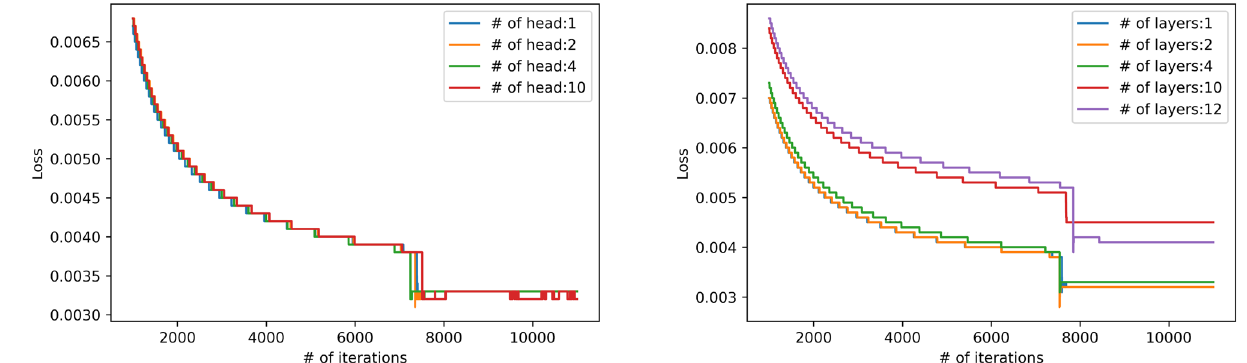
Figure 3. Pre-training analysis with respect to the number of transformer layers and attention